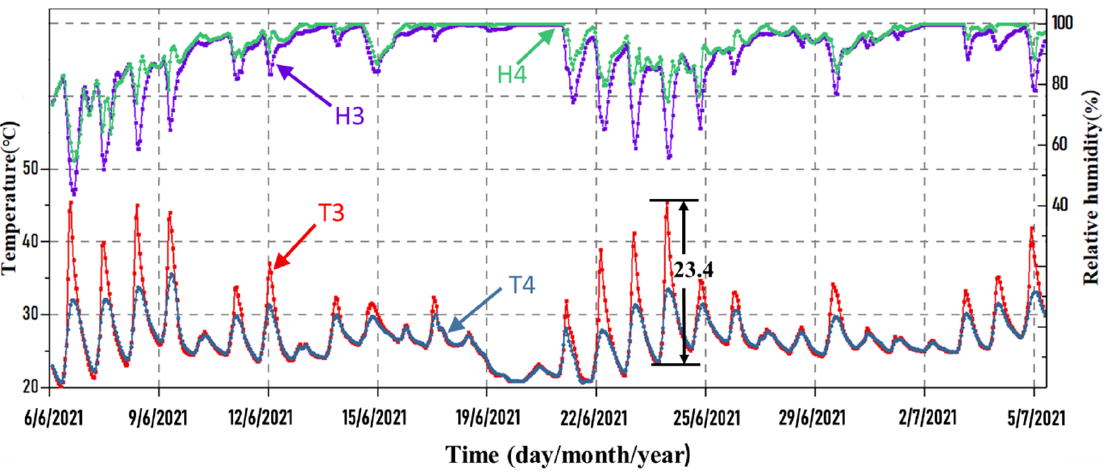
Figure 8. Temperature and relative humidity of the wall surface in the house (6 June 2021–5 July 2021).